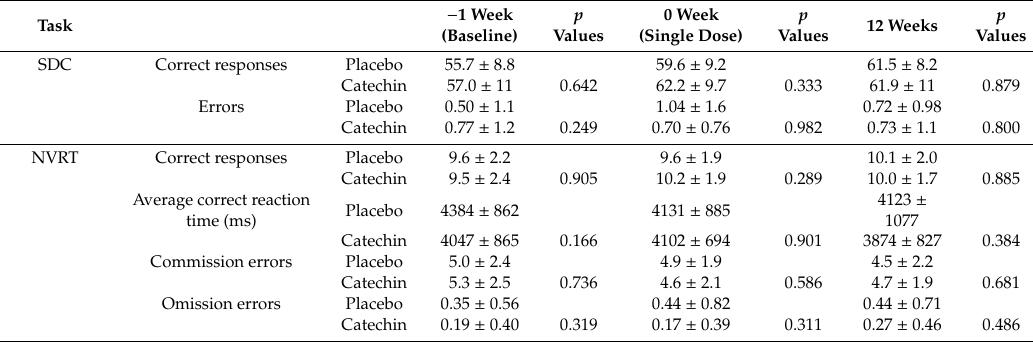
Table 6. E ff ects of green tea catechins on visual information processing-related tasks. Task